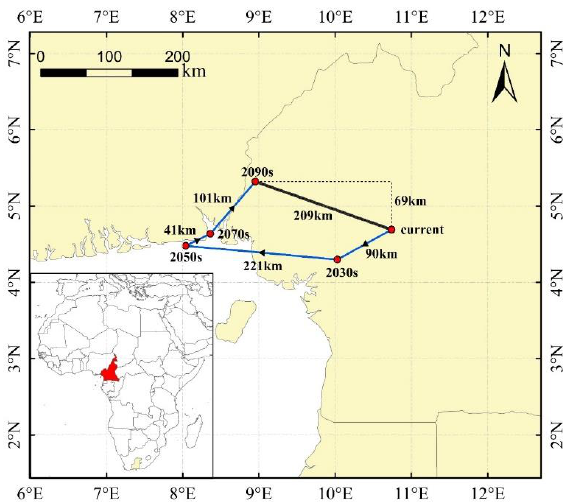
Figure 9. Changes in geographical centers of the potential distribution areas of Anthonomus grandis in the different periods.